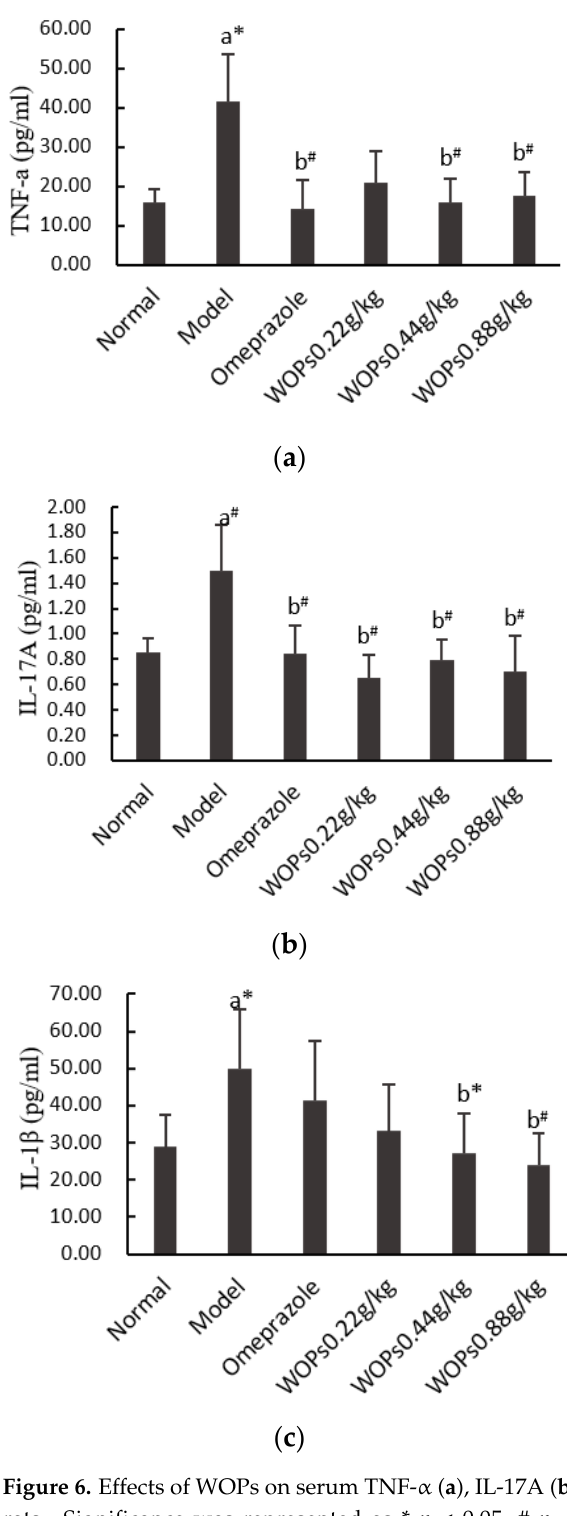
Figure 6. Effects of WOPs on serum TNF- α ( a ), IL-17A ( b ), IL-1 β ( c ) levels in indomethacin-treated rats. Significance was represented as * p < 0.05, # p < 0.01; a—compared with normal group, b—compared with model group; 10 per group. Tumor necrosis factor α —TNF- α ; interleukin (IL)-17A—IL-17A; interleukin (IL)-1 β —IL-1 β ; WOPs—walnut oligopeptides.